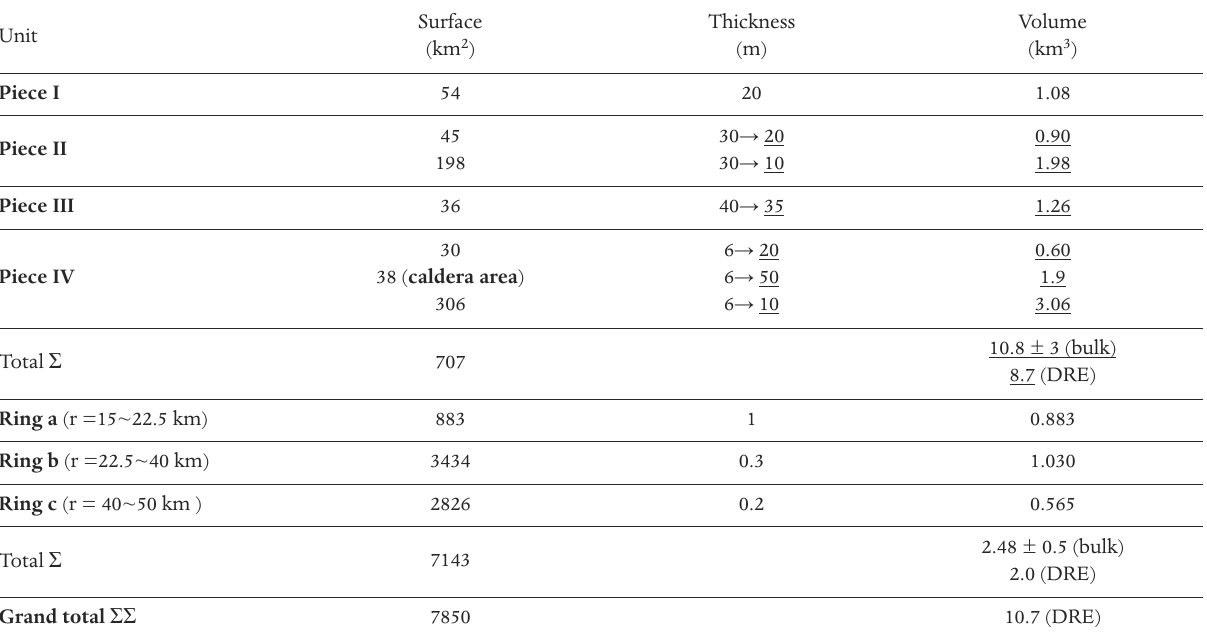
Table 2. Revised values of Verbeek’s estimation in an area of 50 km in radius from the centre of the explosion. The deposits are mostly py- roclastic flows. Underlined values are revised ones. “caldera area” in Piece IV is the same as a hatched area in Figure